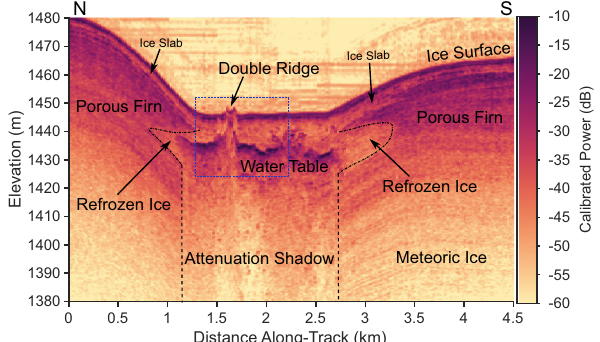
Fig. 2 May 2016 MCoRDS radargram showing the double ridge. The color scale shows the calibrated received radar power with darker colors indicating a stronger return. The dashed blue box outlines the region shown in more detail in Fig. 3. This radargram shows the full crystallizing sill perched within the porous fi rn beneath the ice slab and resting on a base of impermeable meteoric ice. The water table is marked by a strong, horizontal, subsurface re fl ection below which no structure is visible due to the high attenuation. A clear split in the water table is visible directly beneath the double ridge. The surrounding region of low re fl ectivity is the refrozen ice